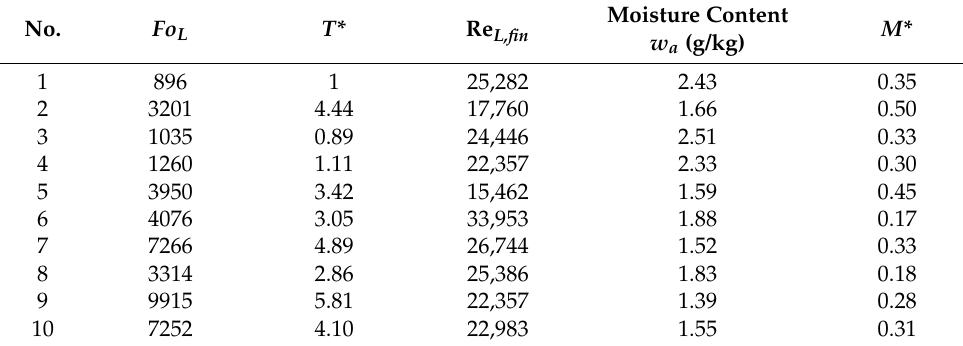
Table 7. Parameter values under different operating